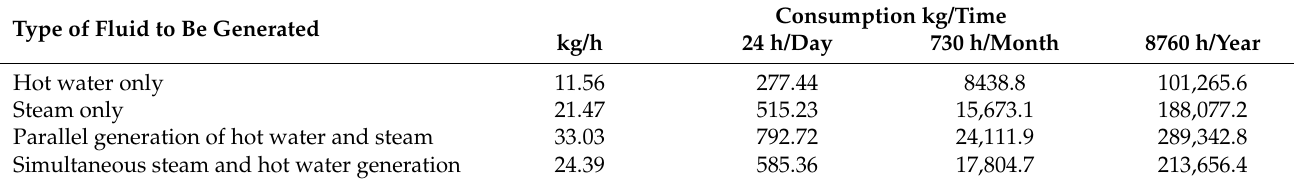
Table 6. LPG fuel